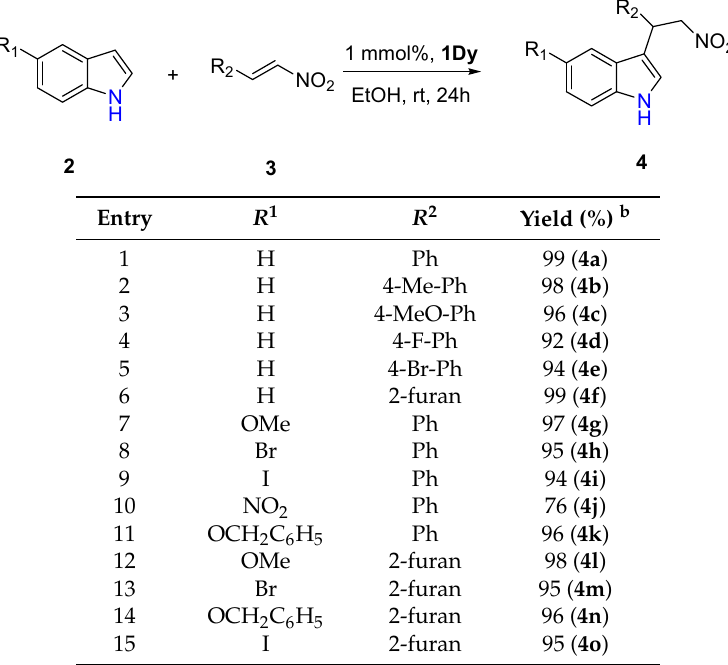
Table 2. Scope of the Friedel–Crafts (FC) alkylation of Indoles with various nitro ‐ styrenes catalysed by 1Dy a .